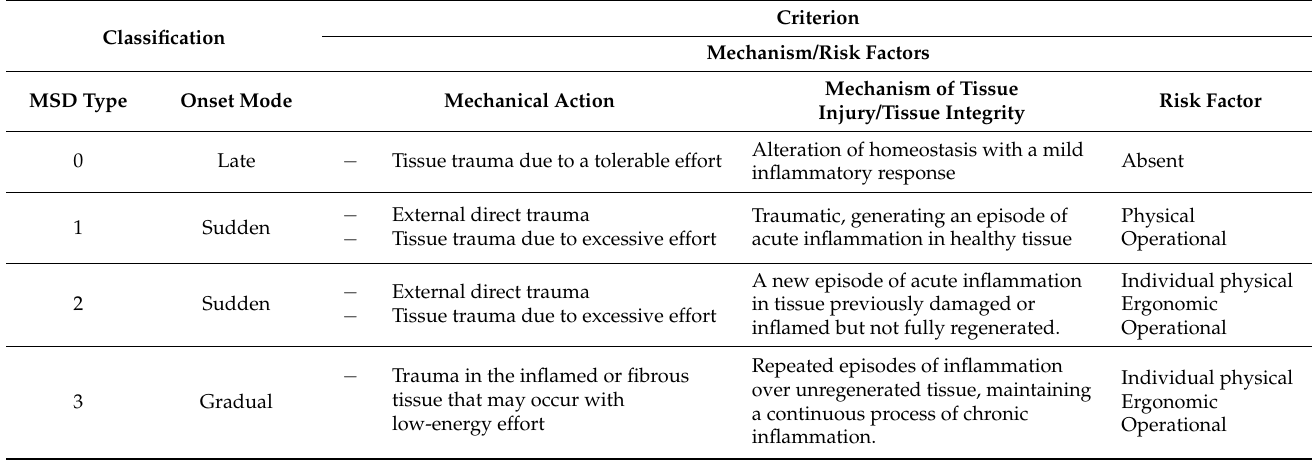
Table 3. Classification according to criteria of injury mechanism and risk factors inherent to activities. Classification